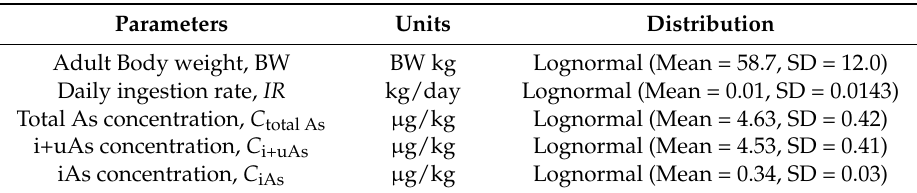
Table A1. Input parameters for Monte-Carlo